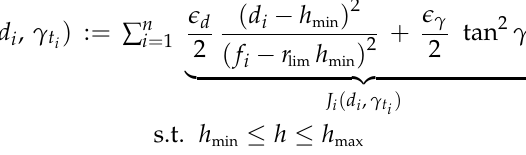
Figure 8. Achieved trade-off between both optimization terms. ( a , b ) Comparison of terms J d J γ , respectively, for varying projected distance l i , under three different values of constant altitude. ti ( c , d ) Comparisons of the same terms for varying altitudes, under three different values of constant l i